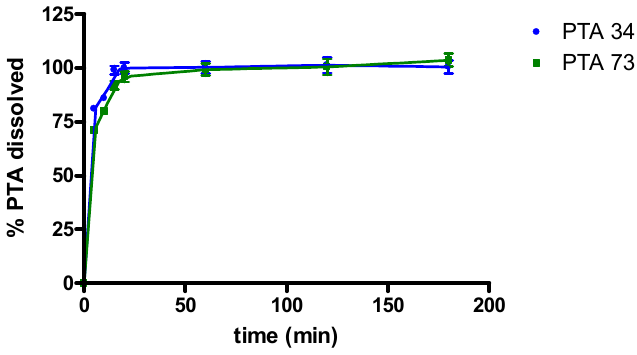
Figure 4. Dissolution profiles of PTA / HP- β -CD solid complexes.